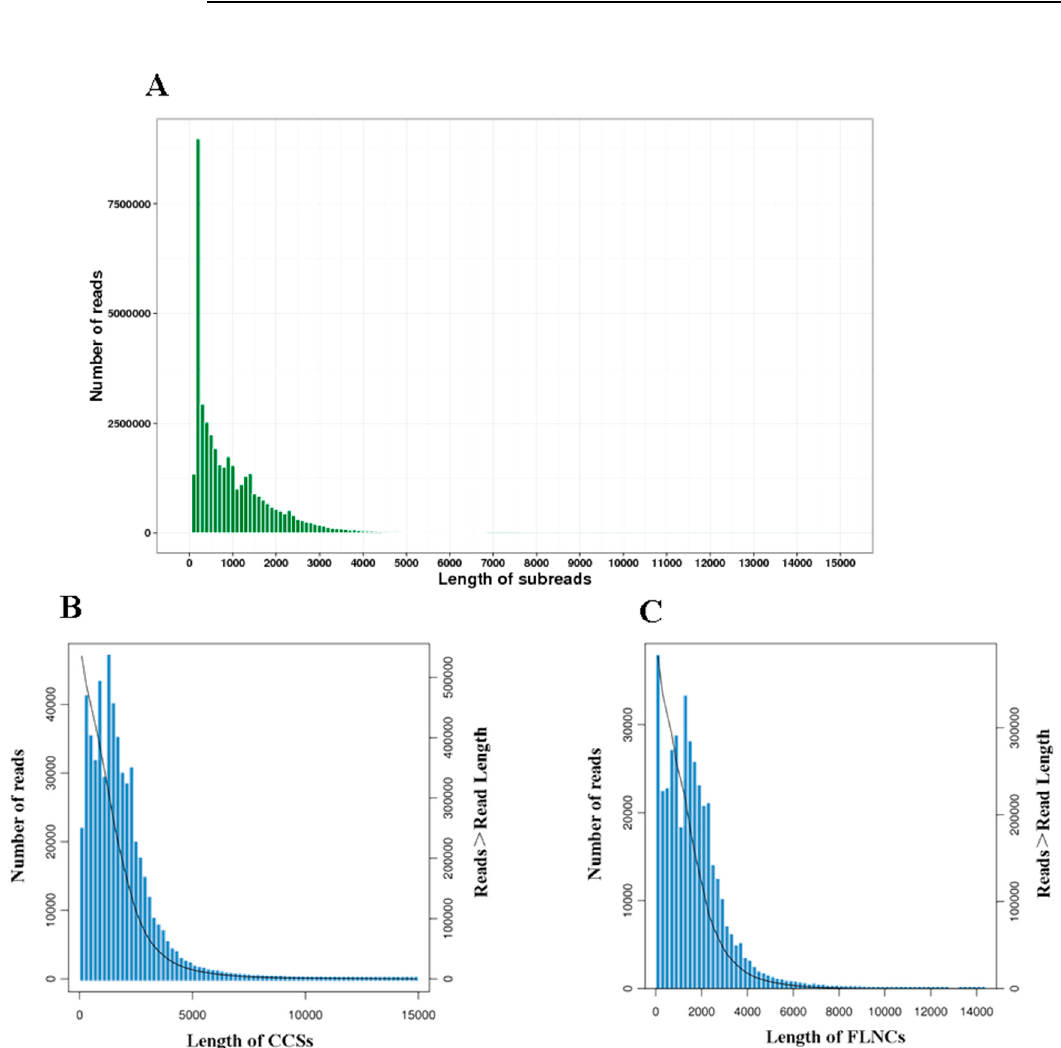
Figure 1. SMRT sequencing of B. dorsalis transcriptomes. ( A ) Length distribution of subreads. ( B ) Length distribution of CCSs. ( C ) Length distribution of FLNCs. Note: The left ordinate represents the number of sequences of this length, and the right ordinate represents the number of sequences whose length is greater than a certain value (X-axis).